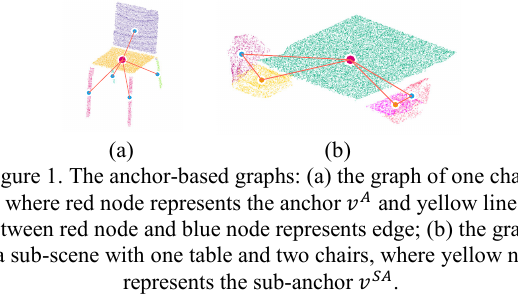
Table 2. The edge